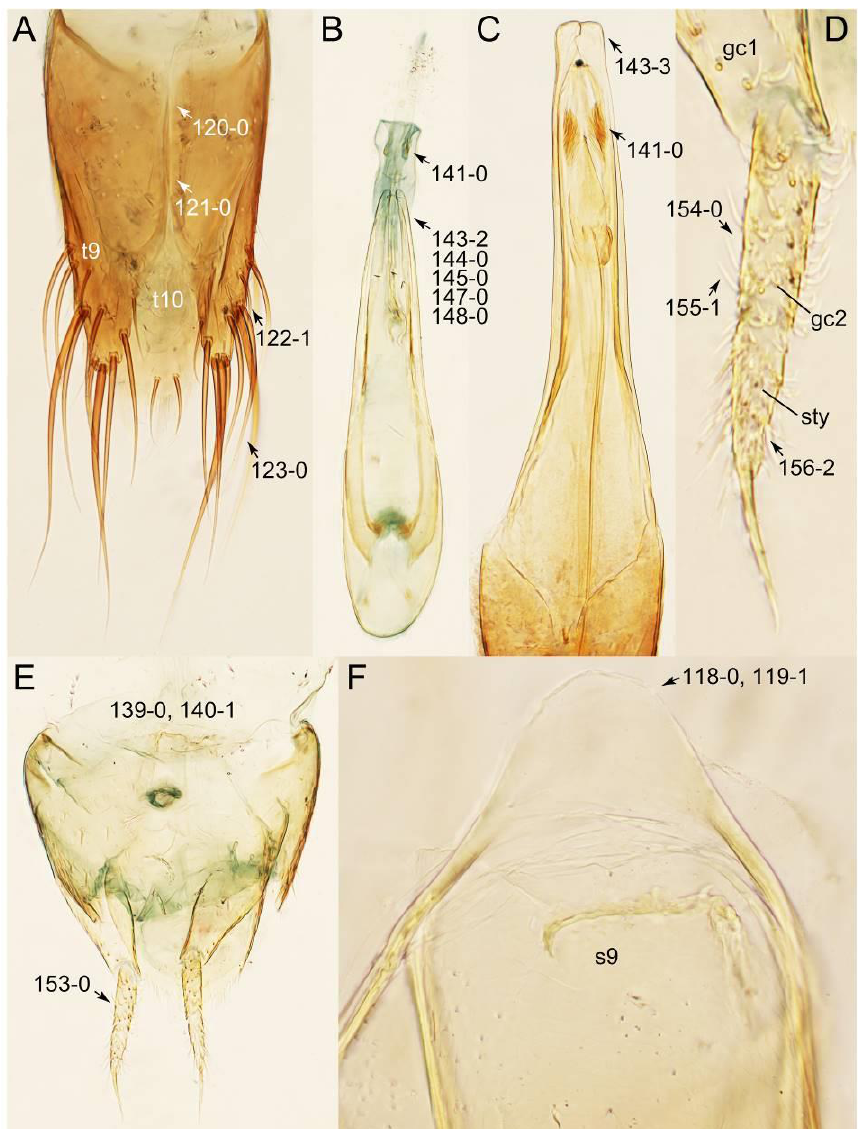
Figure 20. Photographs of body parts of Tachyporini: Euconosomatina, enlarged. ( A ) male tergites IX–X of Sepedophilus cinctulus , dorsal view. ( B ) male aedeagus of Sepedophilus cinctulus , ventral view. ( C ) male aedeagus of Sepedophilus littoreus , ventral view. ( D ) female left gonocoxites and gonostylus of Sepedophilus cinctulus , dorsal view. ( E ) female genital segments of Sepedophilus cinctulus , ventral view. ( F ) male tergite IX and sternite X of Sepedophilus crassus , dorsal view. Abbreviations: gc1–2, gonocoxite 1–2; s9, sternite IX; sty, gonostylus; t9–10, tergite IX–X. Characters and character states (format X-X) are indicated on each figure.